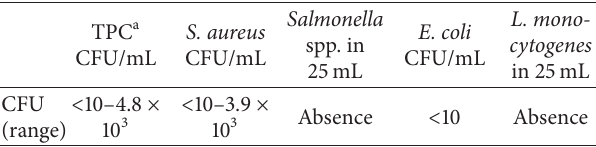
Table 1: Results of 60 raw milk specimens. The range of cell counts from all samples is presented in colony forming units per milliliter